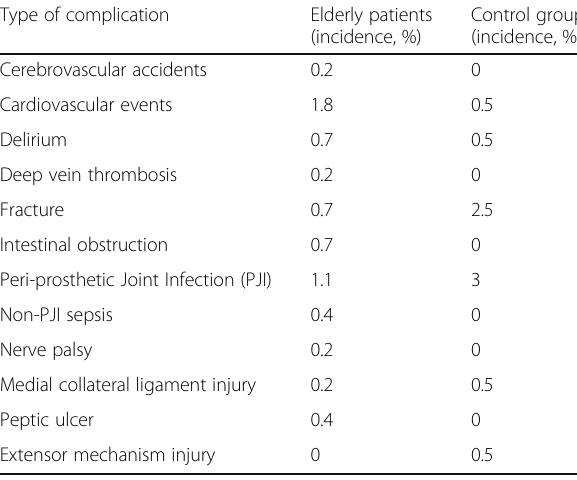
Control group (incidence, %) (incidence,